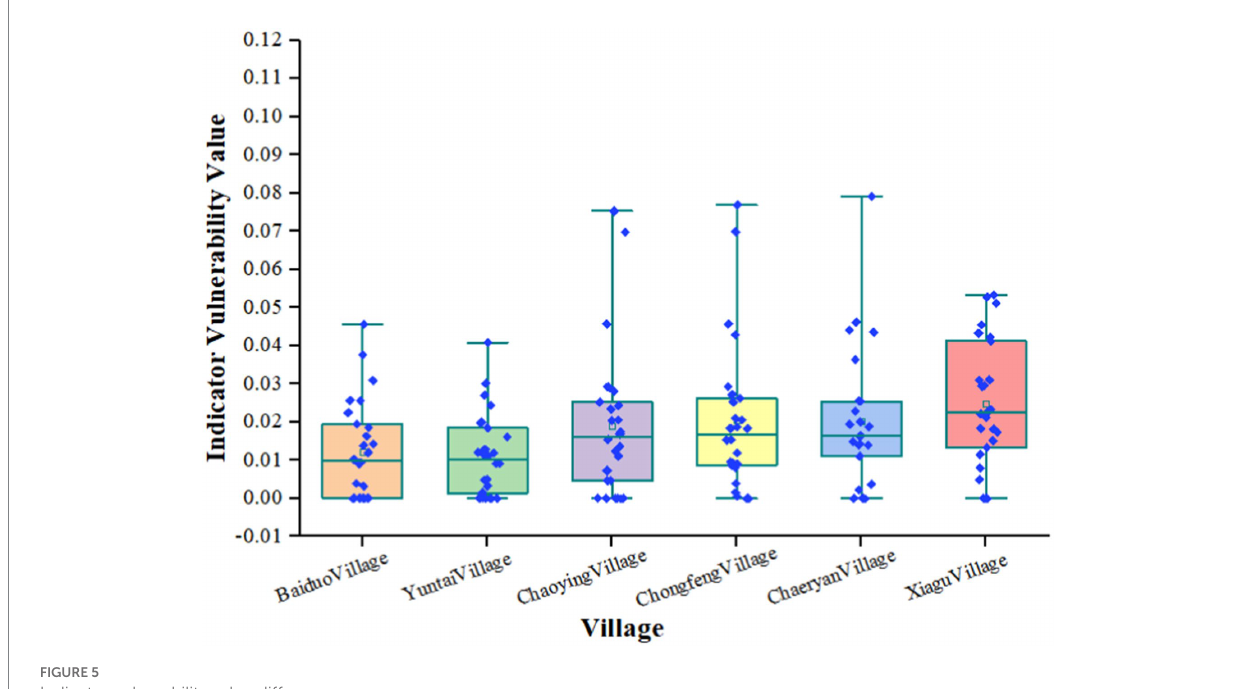
FIGURE 5 Indicator vulnerability value